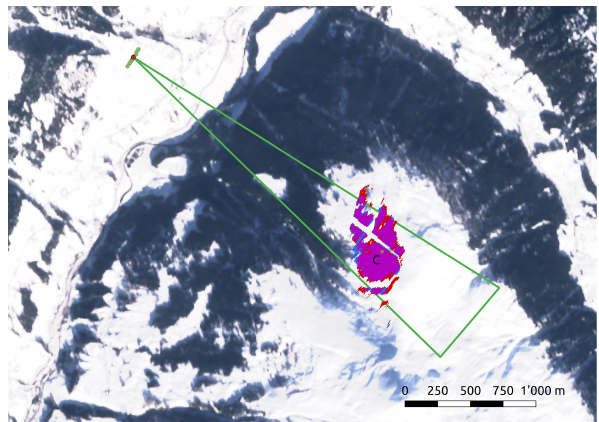
Figure 1. Map of the ground-based bistatic radar experiment. The position of the fixed transmitter (red dot) and the different receiver positions (green dots) are marked in the upper left corner and form the bistatic baseline b . The green triangle marks the − 3dB antenna beamwidth of 12 ◦ of the receiver device. The antennas are oriented towards the snow-covered northwest face of the mountain Riner- horn, Switzerland. The region of interest (ROI) for the winter and summer seasons is shown in blue and red respectively. Their over- lap is shown in purple. C is a reference point for the orientation of the bistatic receiver (see Fig. 4). The hollow line slicing through the ROI masks out metallic beams from a ski lift on the slope. Satellite imagery data: Sentinel-2 on 20 February 2021. Modified Coperni- cus Sentinel data 2021/Sentinel